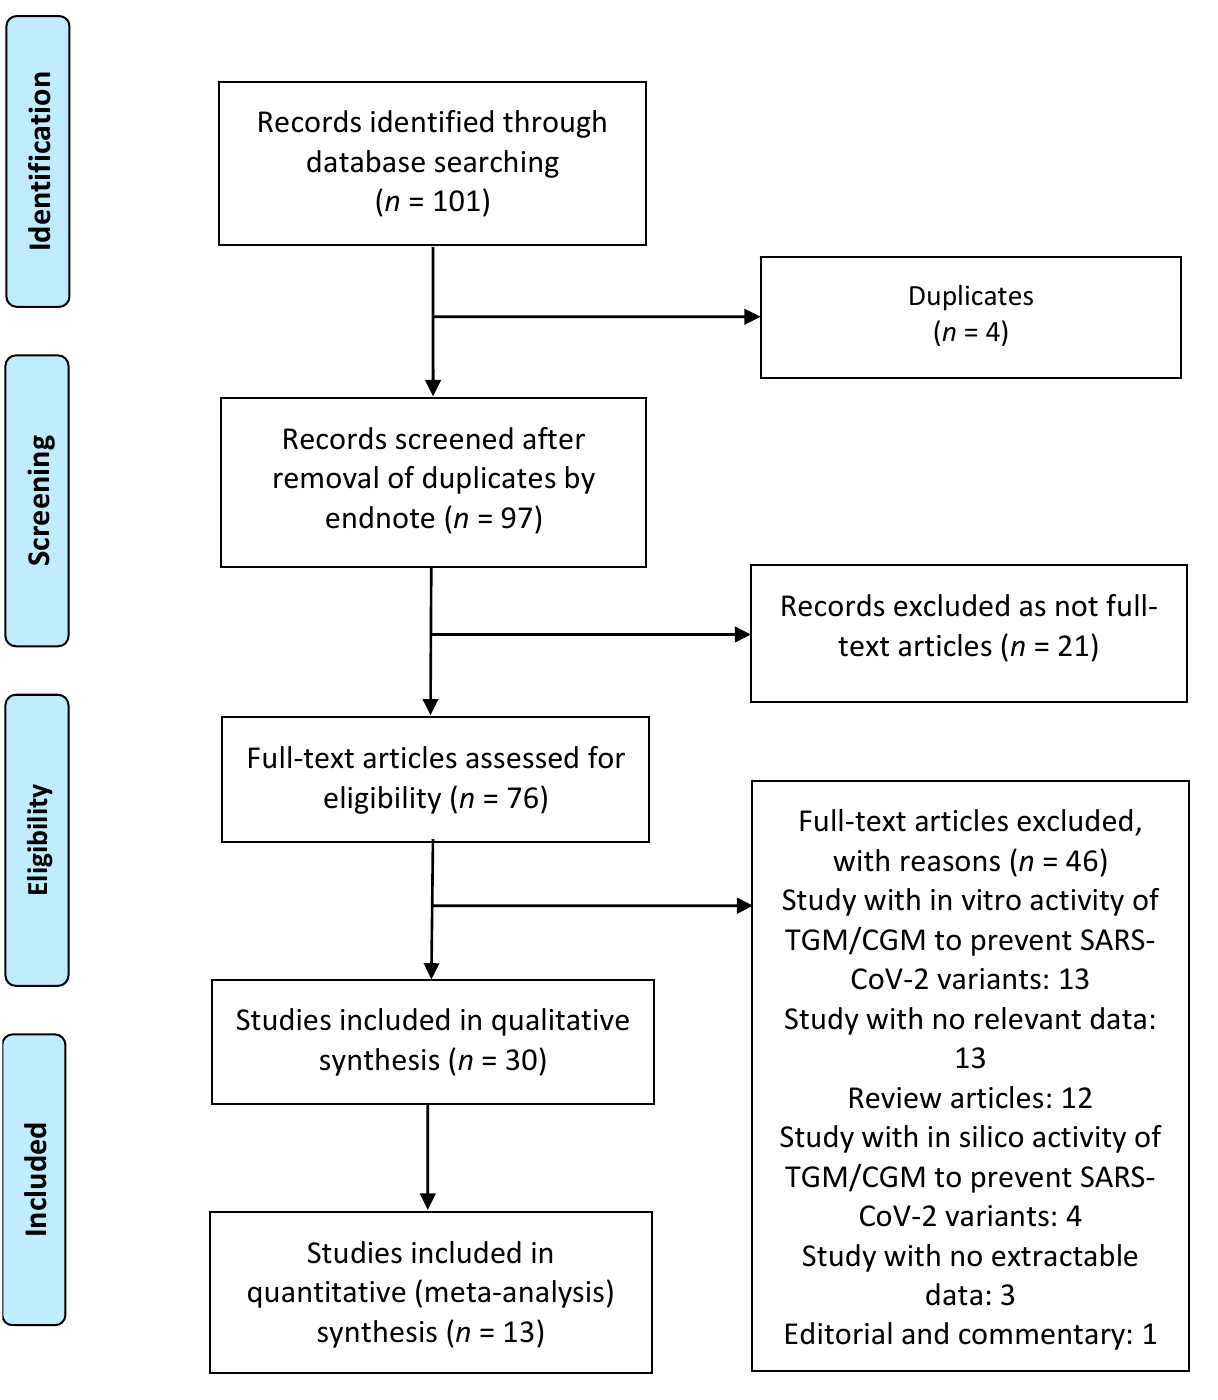
Figure 2. Preferred Reporting Items for Systematic reviews and Meta-Analysis (PRISMA) flow chart of the included studies. SARS-CoV-2, severe acute respiratory syndrome coronavirus 2; TGM/CGM, tixagevimab/cilgavimab.